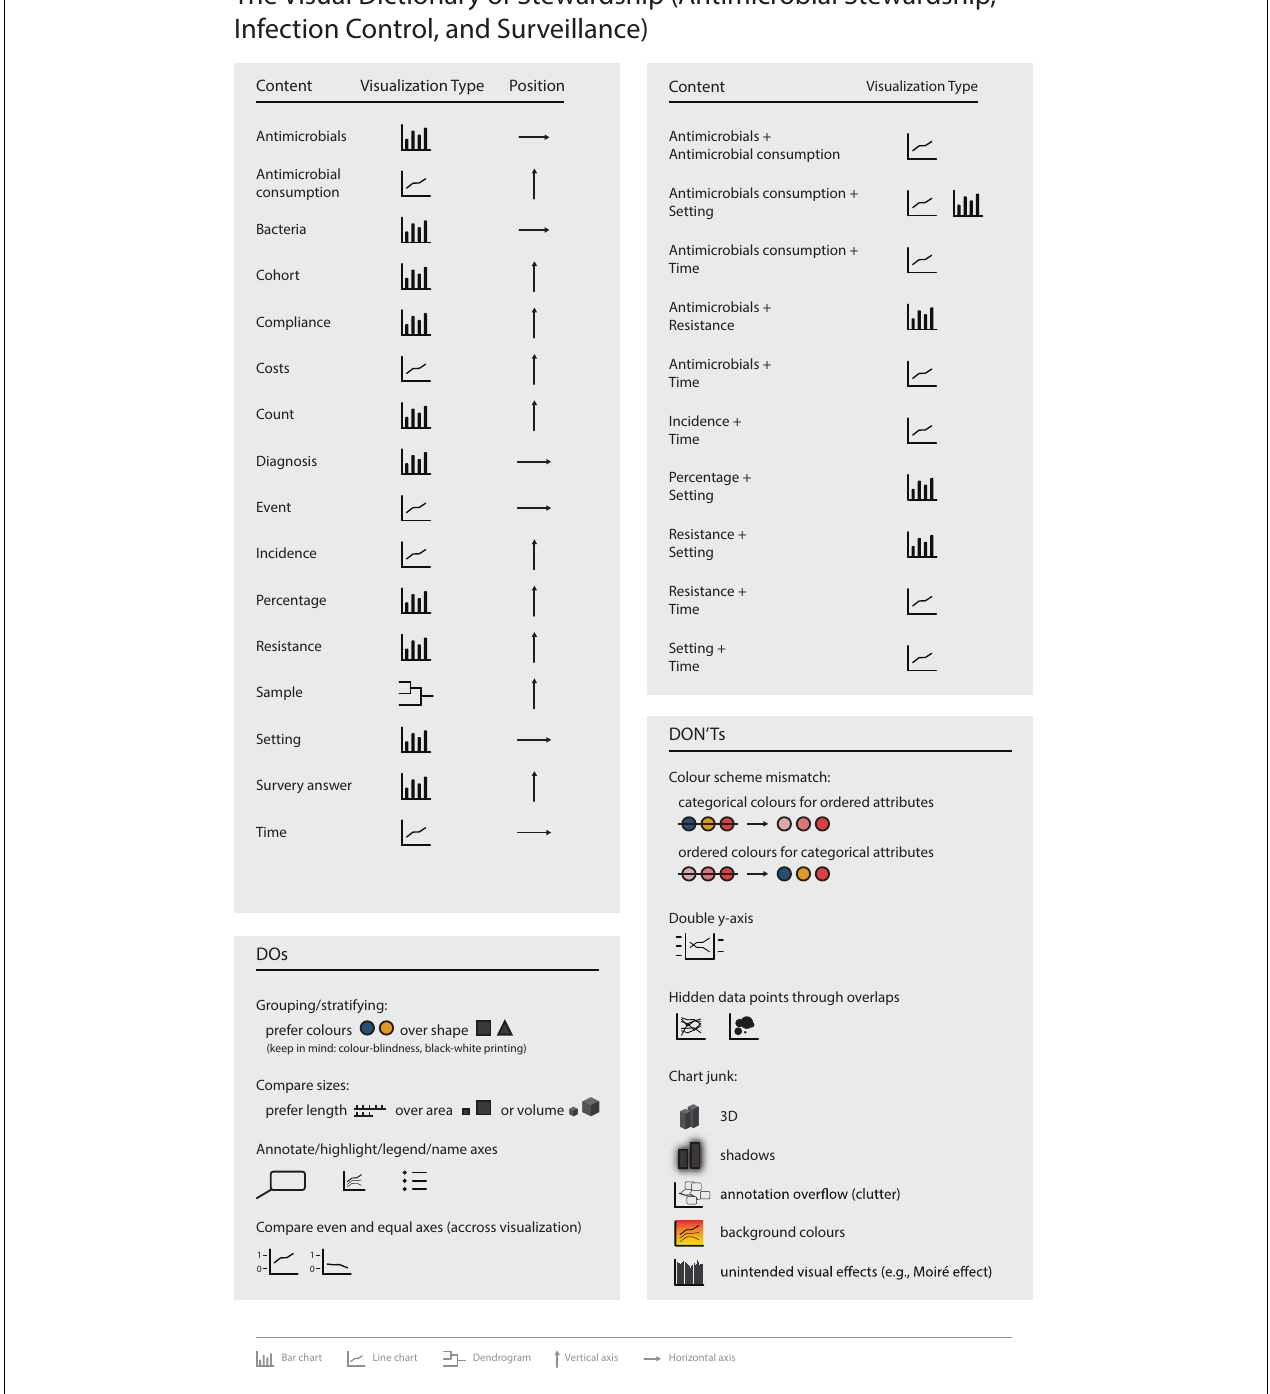
FIGURE 6 | The visual dictionary of stewardship (antimicrobial stewardship, infection control, and institutional surveillance).